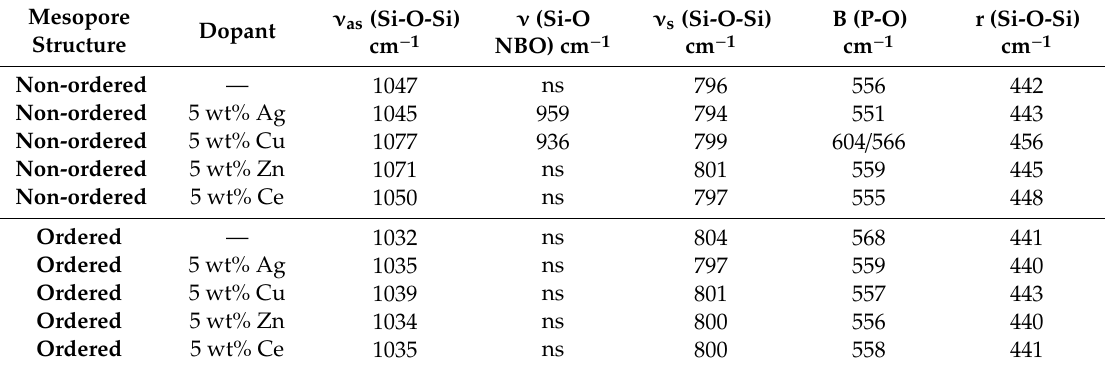
Table 4. Theoretical and experimental wt% compositions of mesoporous silicate glasses.